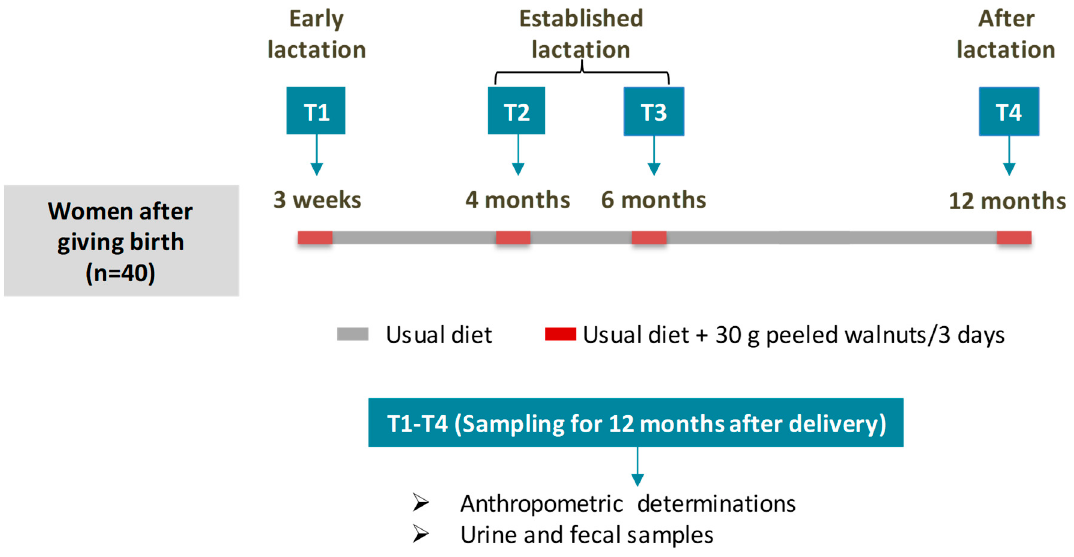
Figure 1. Study design of mothers through postpartum.